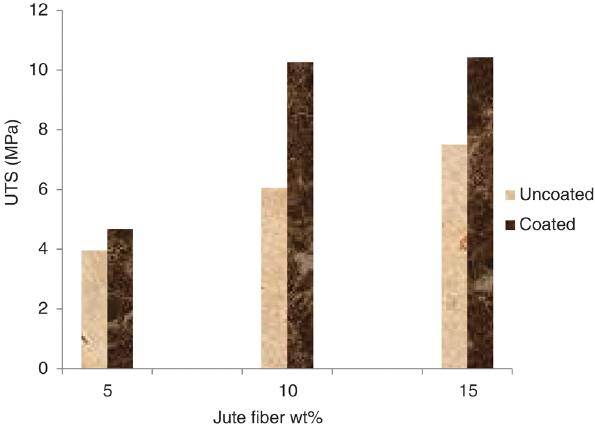
Figure 11: UTS for coated and uncoated samples.